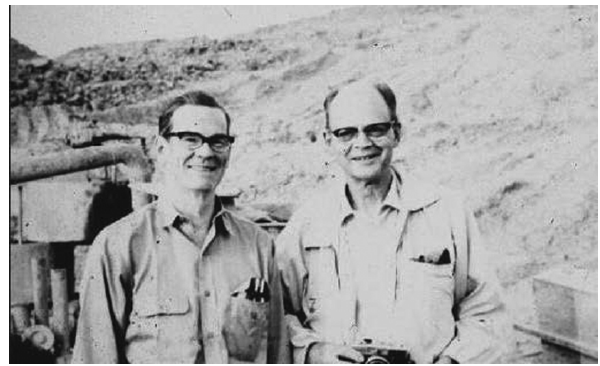
Figure 1. Ralph Peck and Arthur Casagrande. Source: Ralph B. Peck Family. All rights